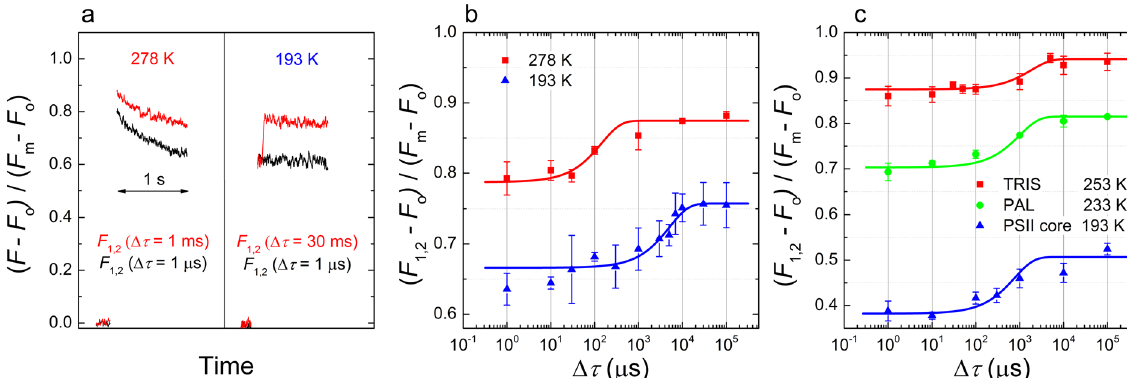
Figure 3. Chlorophyll- a fluorescence induced by double flashes. Kinetic traces of the F 1 -to- F 2 increment with two different dark times ( Δτ ) between the first and second flashes, at two different temperatures in isolated spinach thylakoid membranes ( a ) and dependences of the F 1 -to- F 2 increments on the waiting time ( Δτ ) between the flashes in thylakoid membranes ( b ), and in TRIS-washed thylakoid membranes, intact cells of the PAL mutant of Synechocystis PCC6803 and in the PSII core particles ( c ) at different temperatures as indicated. F 1,2 denotes the fluorescence intensity level following the first double